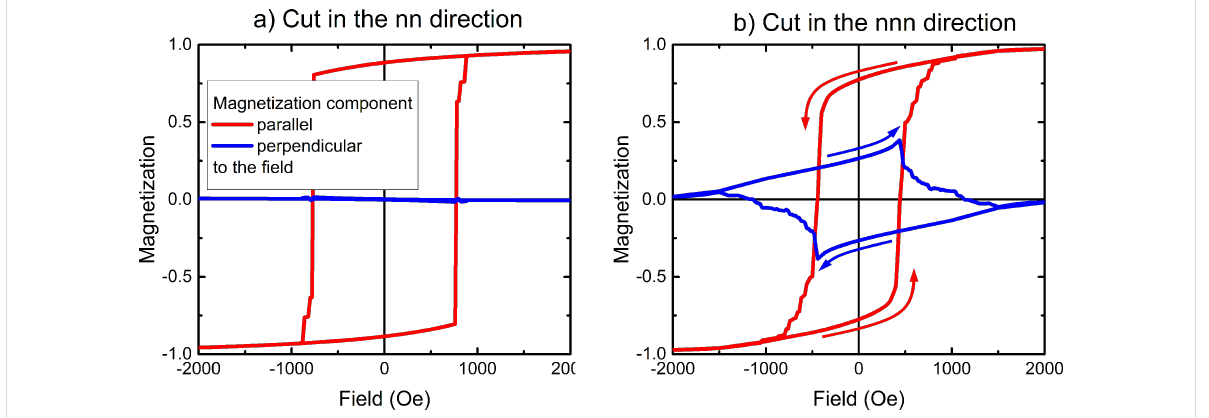
Figure 9: Micromagnetic simulation of hysteresis curves corresponding to the AMR measurements. Hysteresis of a 2 × 2 µm 2 sample piece is calcu- lated for the magnetic field applied along the nn-direction (a) and along the nnn-direction (b). Magnetisation component along the field (usually shown in hysteresis figures) is marked in red. Orthogonal component (in-plane of the antidot matrix) is shown in blue. Panel b) reproduced with permission from [29], copyright 2013 IOP Publishing Limited.